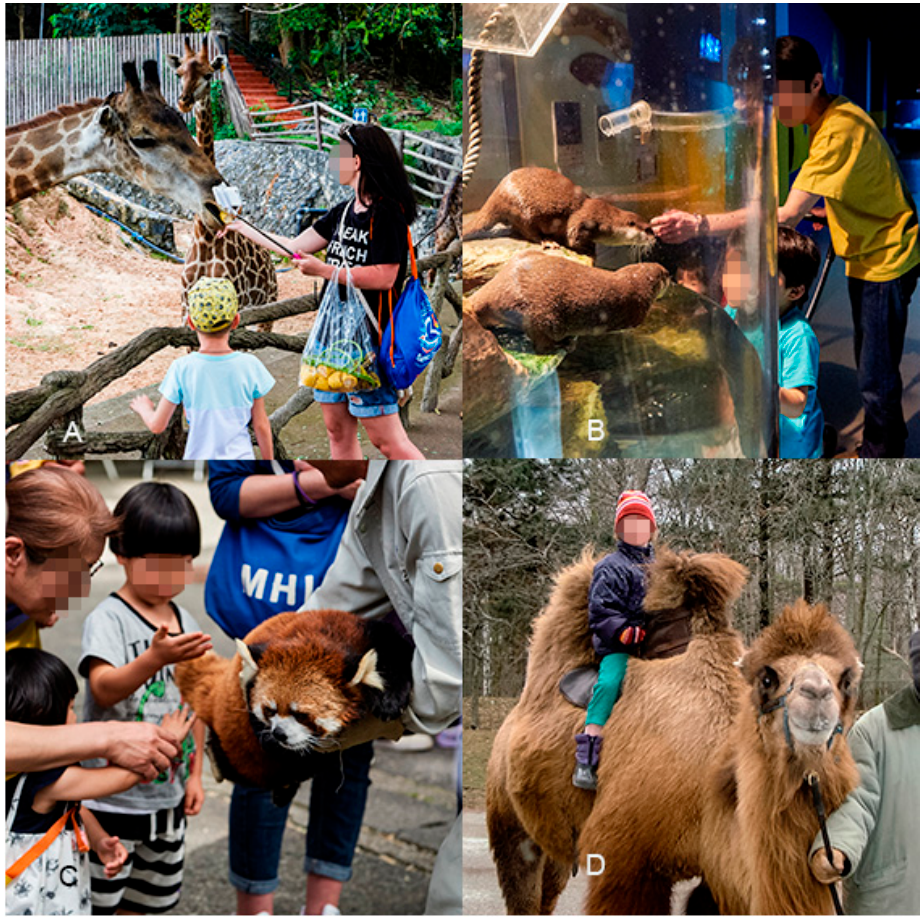
Figure 2. Example images for four of the different AVI types described in this study: ( A ) Hand feeding of a giraffe ( Giraffa sp.); ( B ) Non-hand feeding of a small-clawed otter ( Aonyx cinereus ); ( C ) Petting of a red panda ( Ailurus fulgens ); ( D ) Riding of a Bactrian camel ( Camelus bactrianus ). Images A, B and C were taken by a field researcher during visits to facilities (copyright Fernando Carniel Machado); image D was obtained via Flickr (copyright Paul (CC BY-SA 2.0)). All images were taken at facilities that fall under the category of belonging to WAZA regional association members, they have been altered to ensure any individuals are made anonymous and are representative of screen shots included in the data set of this study.